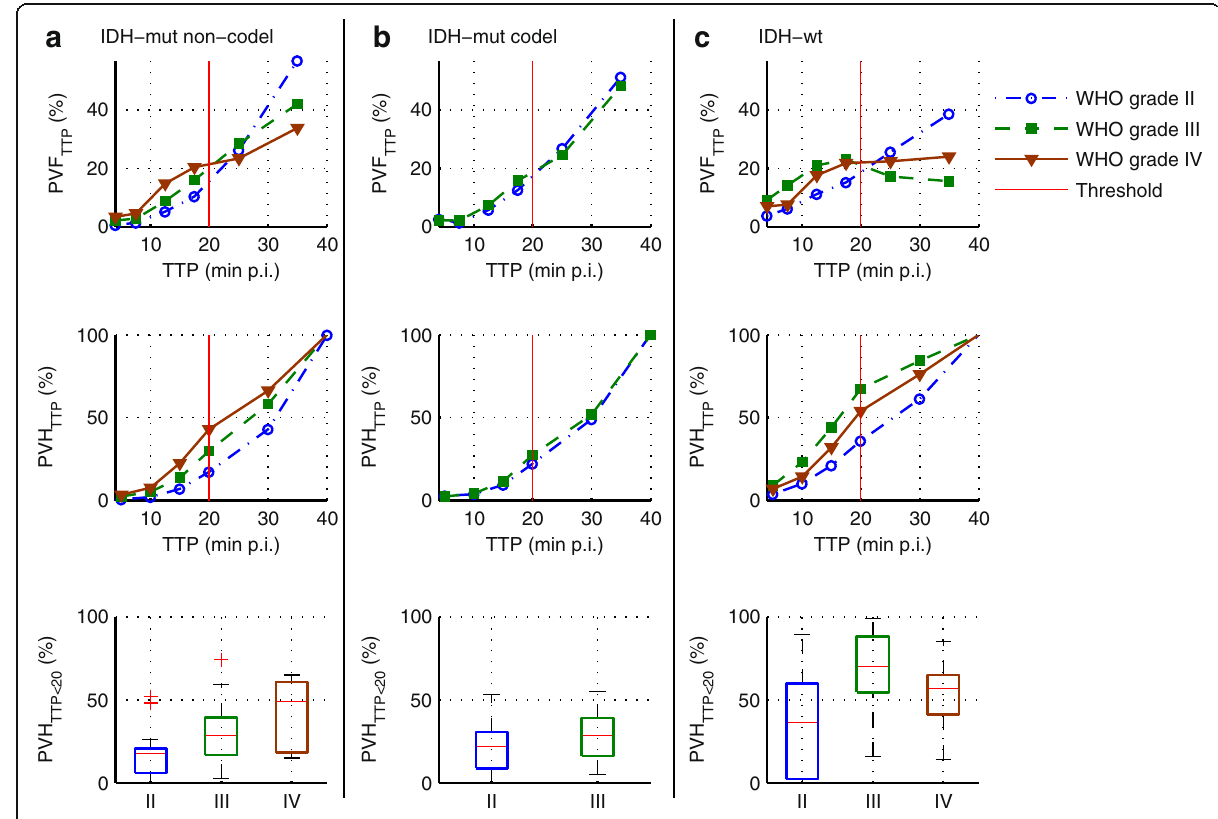
Fig. 2 The upper row shows the average percentage volume fractions of the TTP (PVF TTP ), i.e. the percentage portion of voxels with TTP in the respective time frame. In the middle row, the corresponding cumulated histograms (PVH TTP ) are presented, i.e. the percentage portion of voxels with TTP below a certain value. The most significant differences between groups were found for PVH TTP<20 (with the cut-off value TTP < 20 min p.i. marked with red lines). The lower row depicts the boxplots of PVH TTP<20 . a IDH -mut non-codel. b IDH -mut codel. c IDH -wt